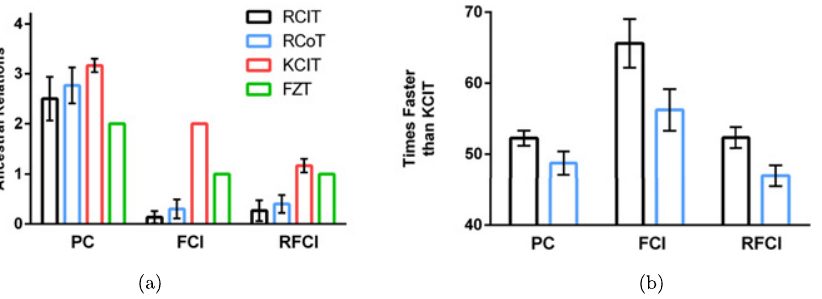
Figure 4: Results of CCD algorithms as evaluated on real longitudinal data. Part (a) displays mean counts of the number of an- cestral relations directed backwards time. We do not display 95% confidence intervals when we computed a standard error of zero. Part (b) summarizes the mean run